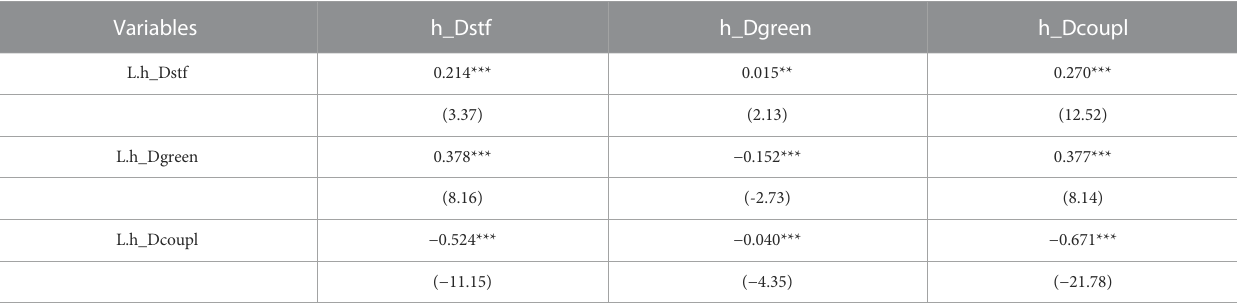
TABLE 10 GMM estimation results of PVAR model.